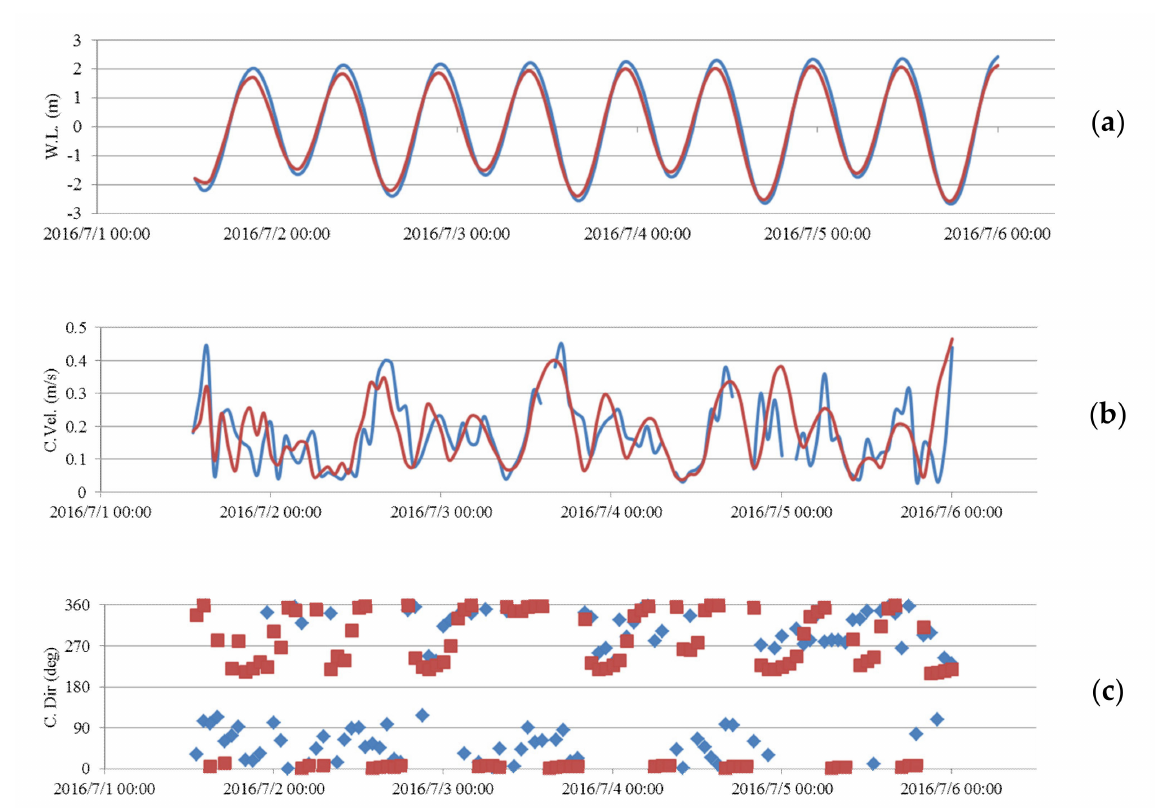
Figure 6. Comparison between the data obtained using the numerical model and the measured ocean currents: ( a ) tidal; ( b ) current velocity; ( c ) current